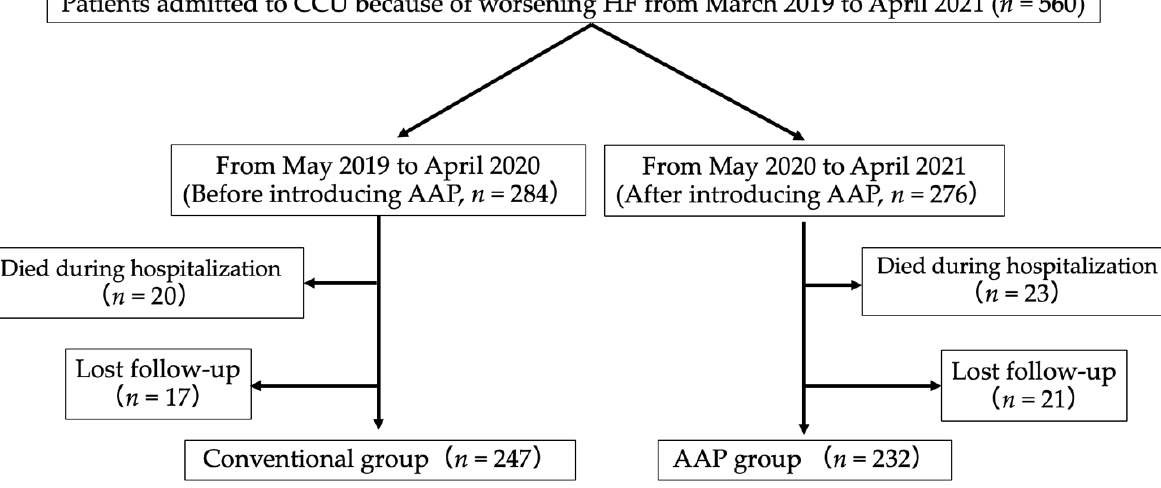
Figure 1. Study flow diagram.